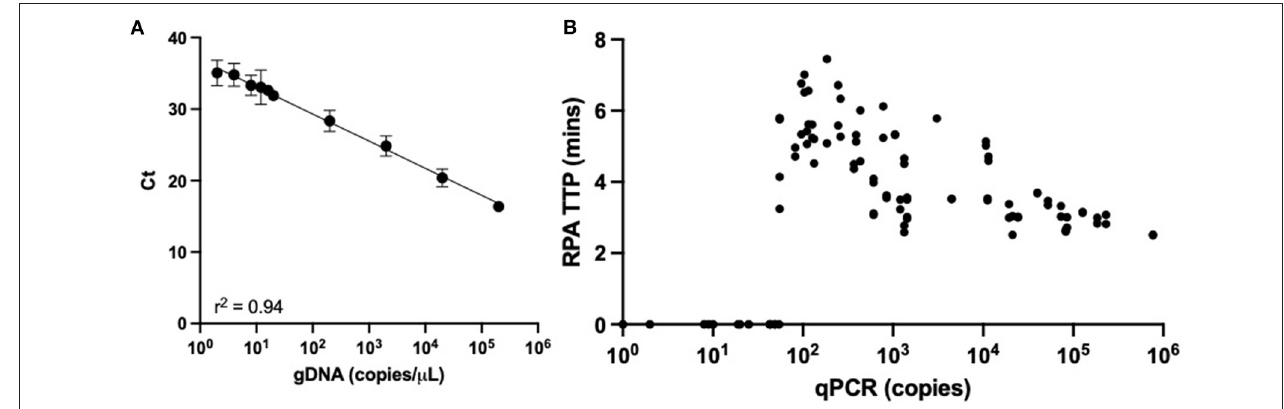
FIGURE 2 | APP-qPCR performance. (A) Regression line from limit of detection of APP-qPCR performed with gDNA from serovar 8 reference strain 405. (B) Relative quantification of APP copy burden for 61 clinical samples with respective APP-RPA time to positive (TTP).